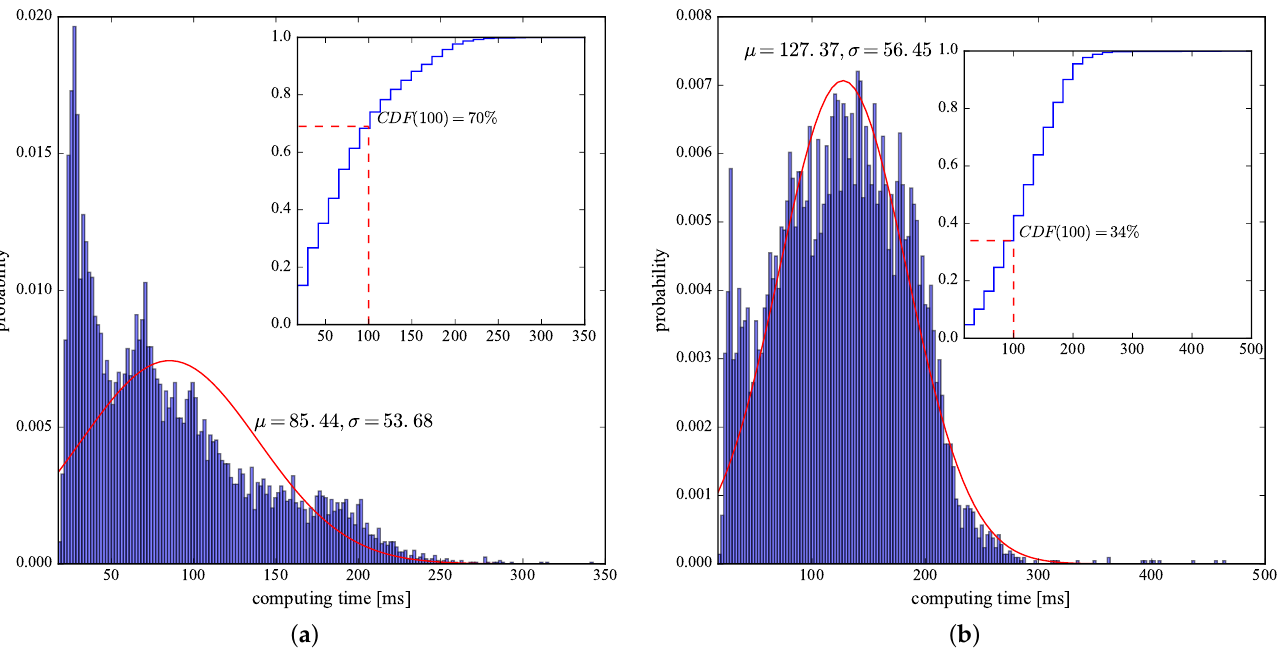
Figure 10. Computing-time comparisons. The histograms and corresponding fitted normal distri- bution curves of computing time using EKF and UKF are given. µ is mean value and σ is standard deviation. In the upper-right boxes, the CDFs of computing time are given. The value of CDF(100) is the rate that the prediction is completed in real time. ( a ) The EKF predictor. ( b ) The UKF